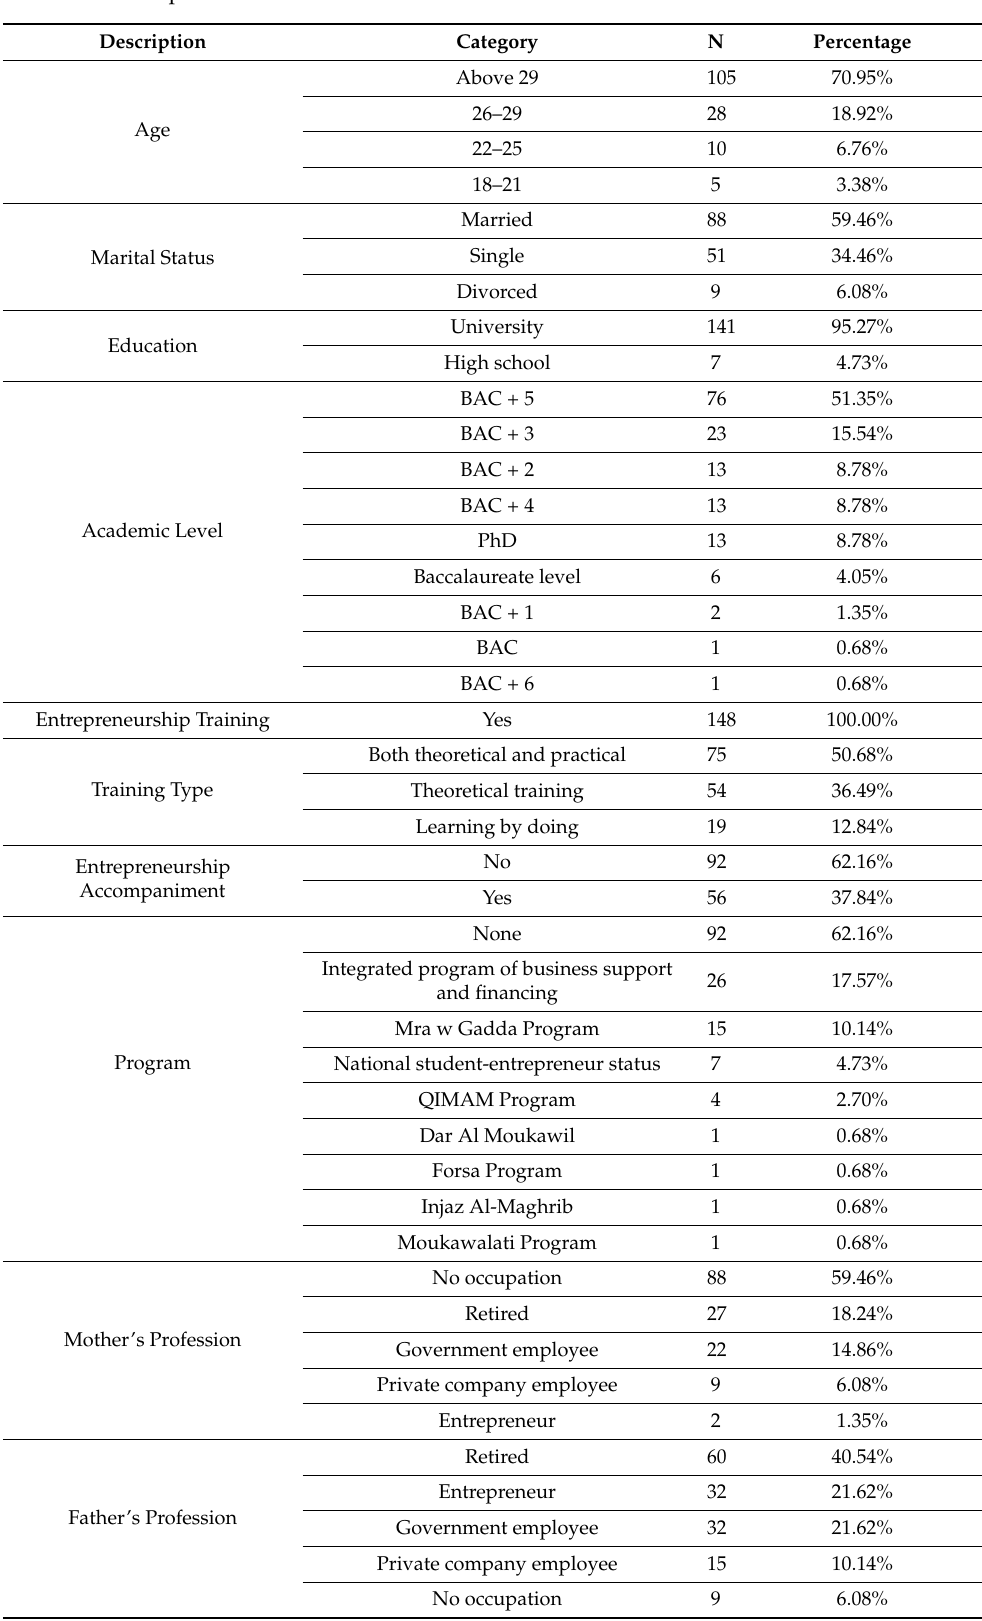
Table A2. Participant